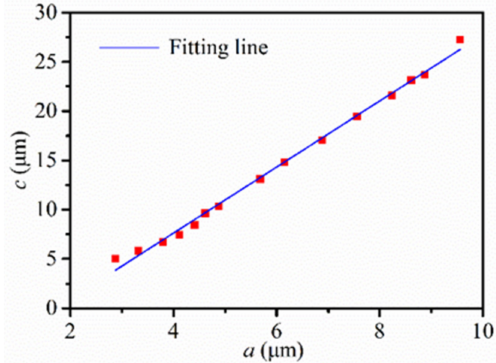
Figure 11. Linear fitting curve of a and c